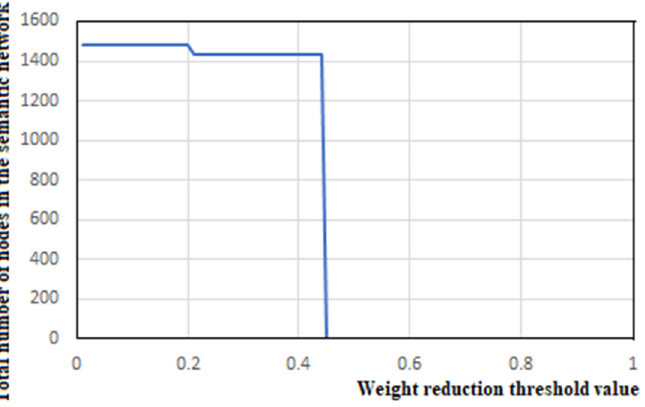
Figure 1. Graphical representation of the dependence of the total number of nodes in the semantic network on the selected value of the bond weight reduction threshold for a document consisting of 50 words.